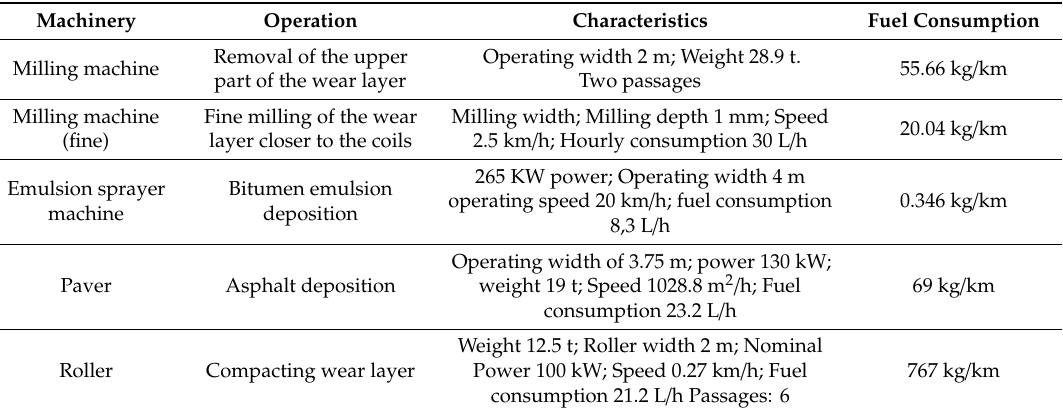
Table 7. The equipment consumptions for wear layer rehabilitation.